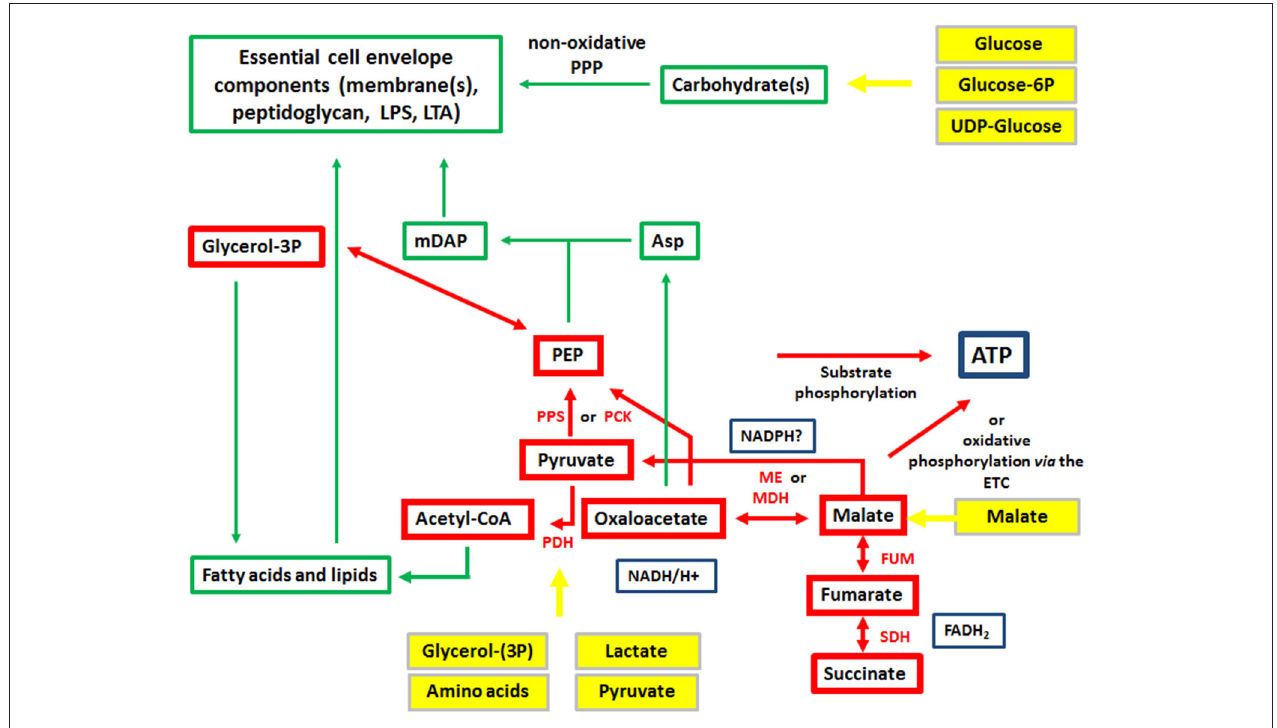
FIGURE 3 | Metabolism of IBPs: metabolites and metabolic reactions common to all IBPs. Red boxes and arrows show the common catabolic products and reactions, respectively and green boxes and arrows the common anabolic products and reactions. Produced co-factors are in blue-framed boxes. Products in yellow boxes and arrows represent nutrients that can be delivered by the host